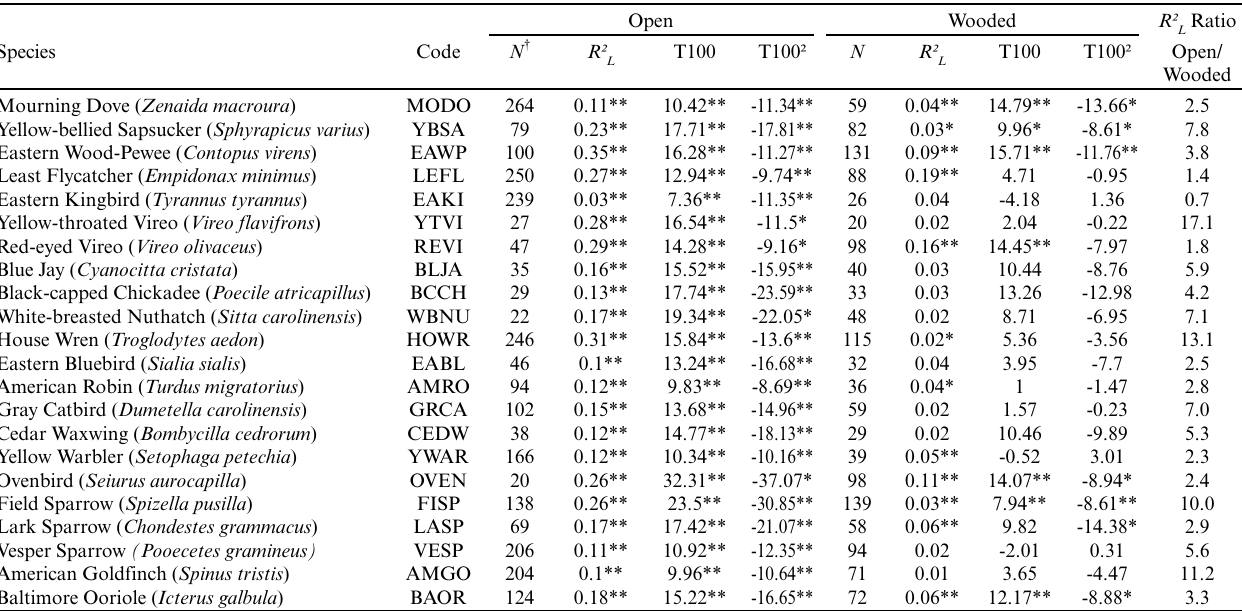
† N = number of observations; R² * p < 0.01 ** p <